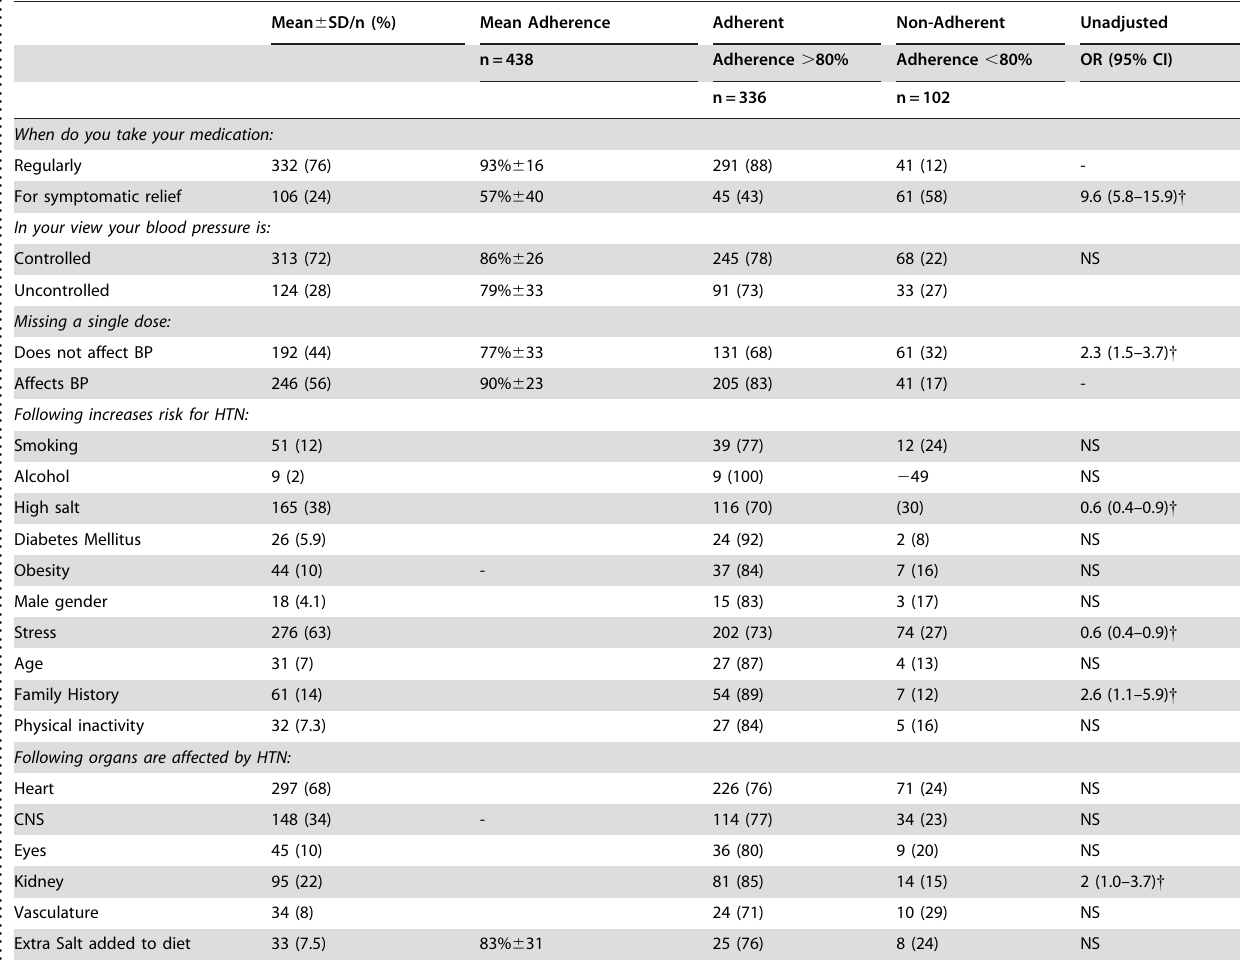
Table 3. Awareness about hypertension and anti-hypertensive treatment .. ... .... ... ... .... ... ... .... ... ... .... ... ... .... ... ... .... ... ... .... ... ... .... ... ... .... ... ... .... ... ... .... ... ... .... ... ... .... ... ... .... ... ... . Mean 6 SD/n (%) Mean Adherence